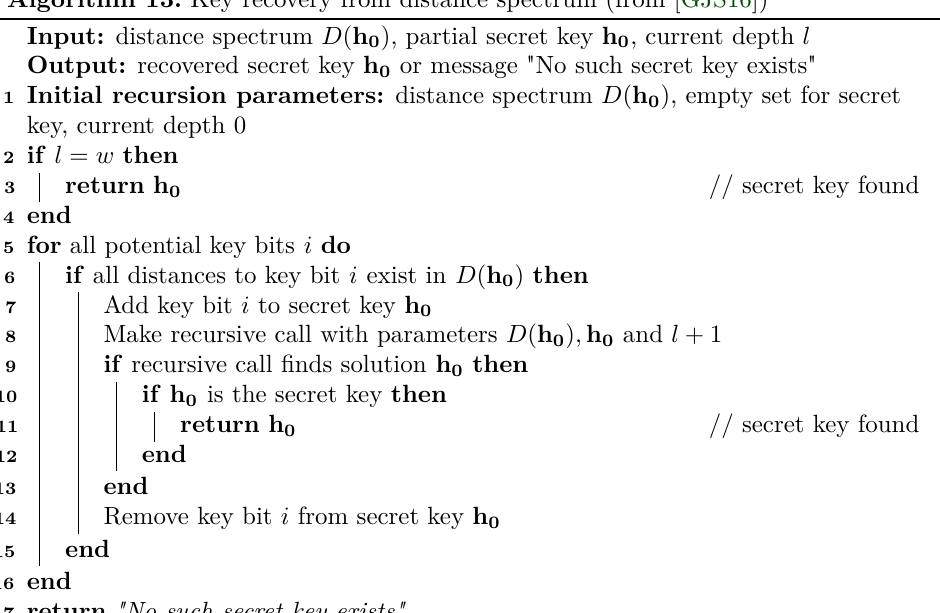
Algorithm 13: Key recovery from distance spectrum (from